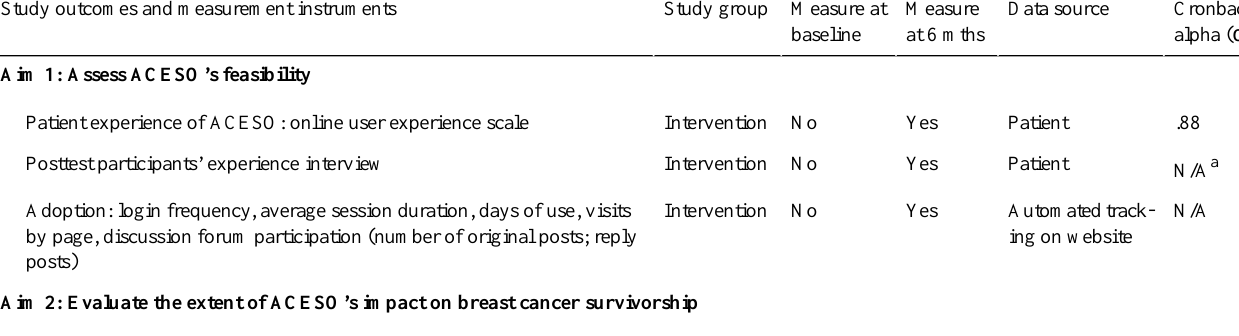
Table 1. Timing and structure of study outcomes at baseline and 6-month postintervention.